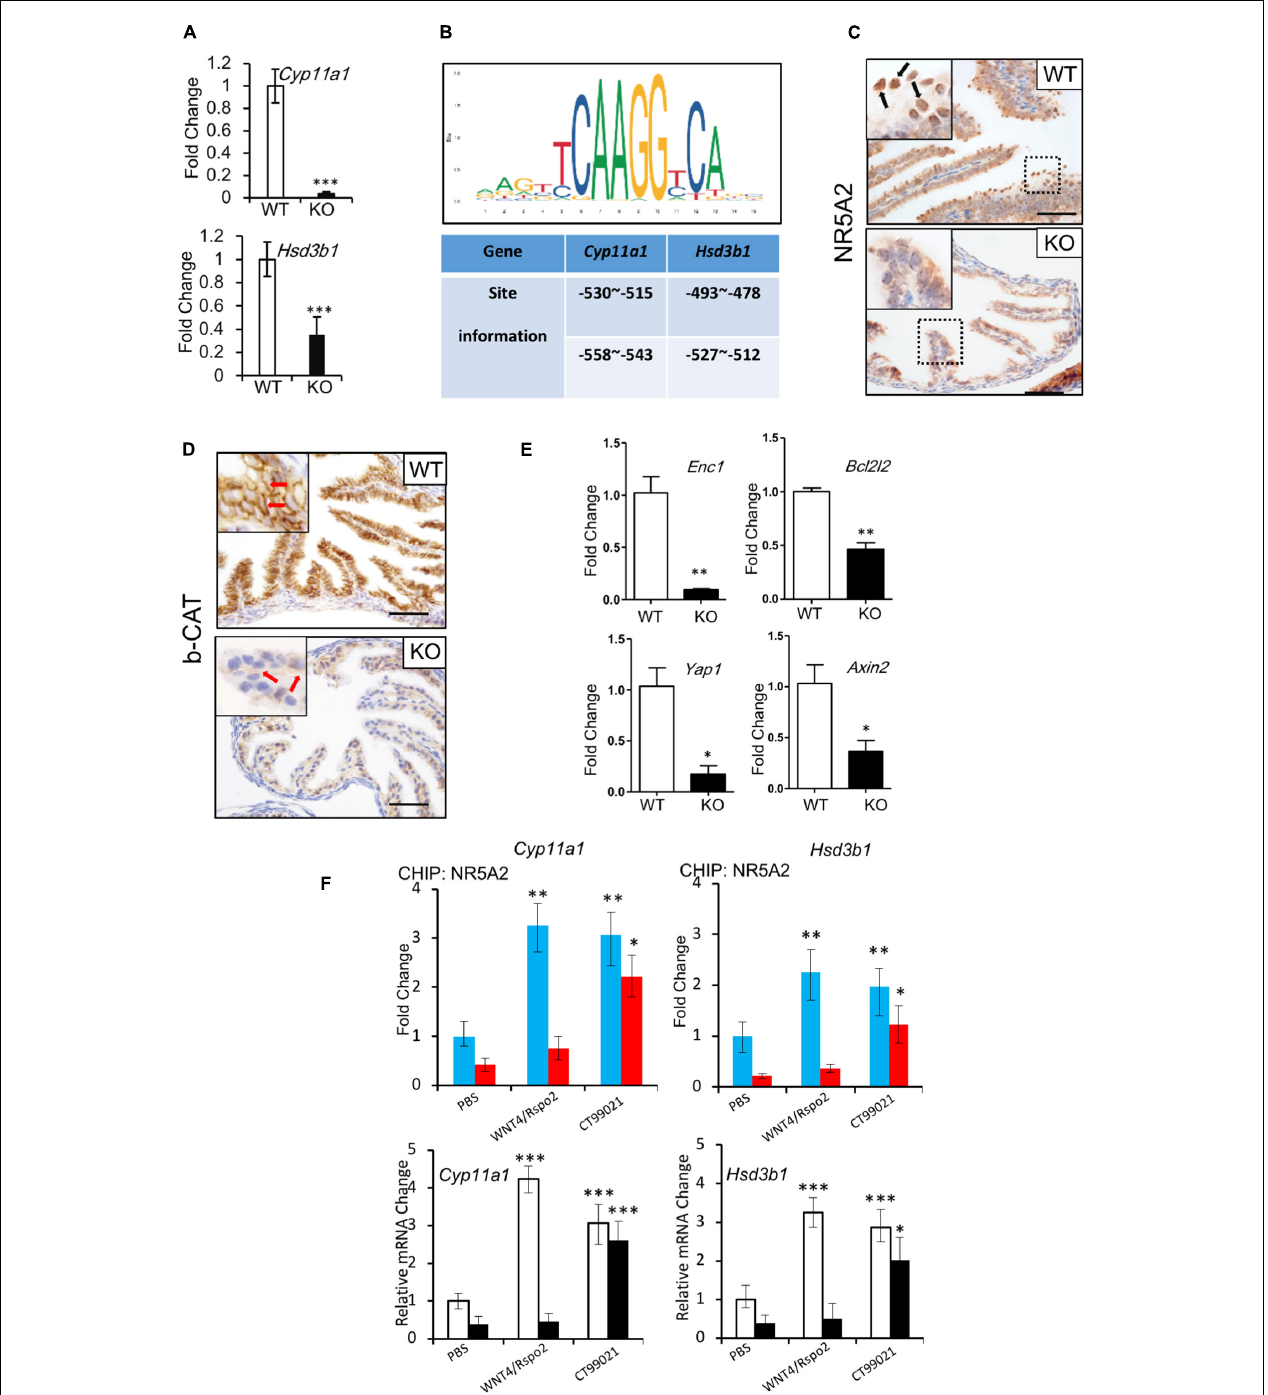
FIGURE 5 | Regulation of NR5A2 activity by LGR4 mediated canonical WNT/CTNNB1 signaling pathway. (A) The mRNA levels of Cyp11a1 and Hsd3b1 in the WT and LGR4 mutant oviducts at the estrus stage. (B) Diagram of conserved NR5A1/2 binding sites in the Cyp11a1 and Hsd3b1 promoters predicted in silico . (C) IHC assays to detect the NR5A2 protein location in the WT or Lgr4 -deficient oviducts. (D) IHC assays to detect the CTNNB1 protein level in the WT or Lgr4 -deficient oviducts. (E) The mRNA levels of WNT target genes in WT and LGR4 mutant oviducts at estrus stage. (F) The chromatin of primary oviductal epithelial cells from WT or Lgr4 mutant mice was immunoprecipitated with a NR5A2 antibody. Immunoprecipitated DNA was amplified with the sets of specific primers for the indicated NR5A2 binding sites in Cyp11a1 and Hsd3b1 promoters (upper panel). The relative fold change of Cyp11a1 and Hsd3b1 genes of the primary oviductal epithelial cells after the treatment of WNT4/RSPO2 or CT99201 (lower panel) are presented. ∗ p ≤ 0.05; ∗∗ p ≤ 0.01; ∗∗∗ p ≤ 0.001. Scale bar, 50 µ m in (C,D) . IHC, immunohistochemistry.